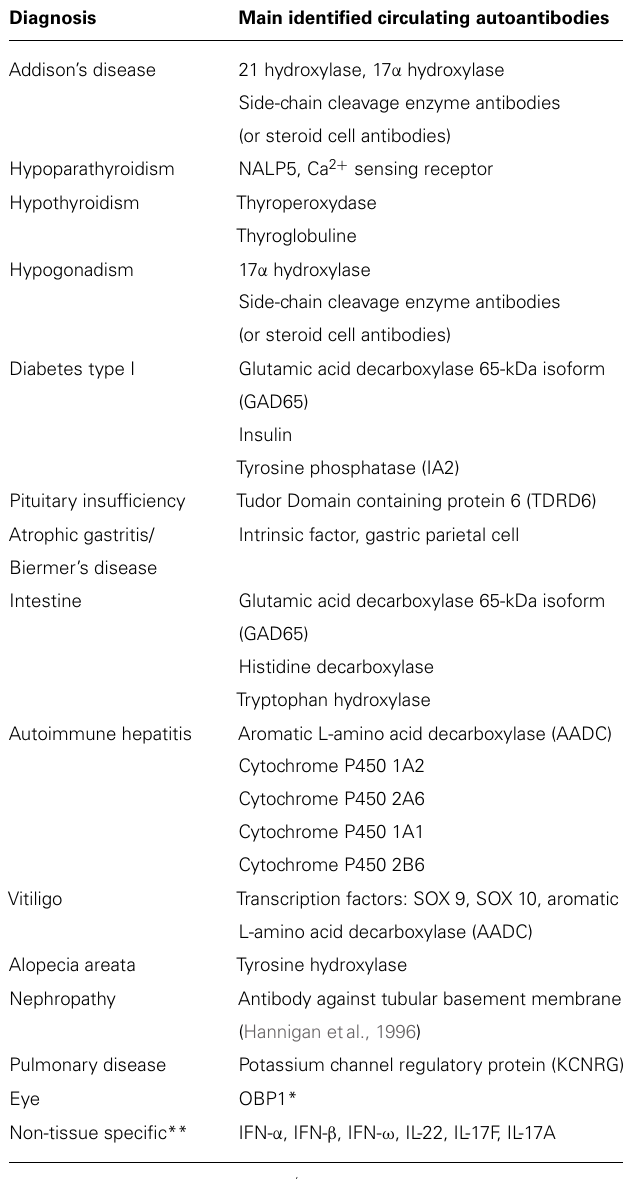
Table 2 | Main identified target of autoimmune antibodies inAPECED